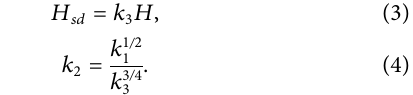
Frontiers in Energy Research |